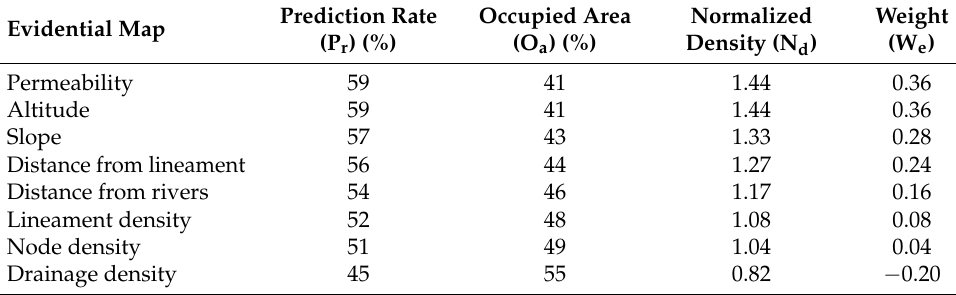
Table 2. The extracted parameters from the intersection point of P-A